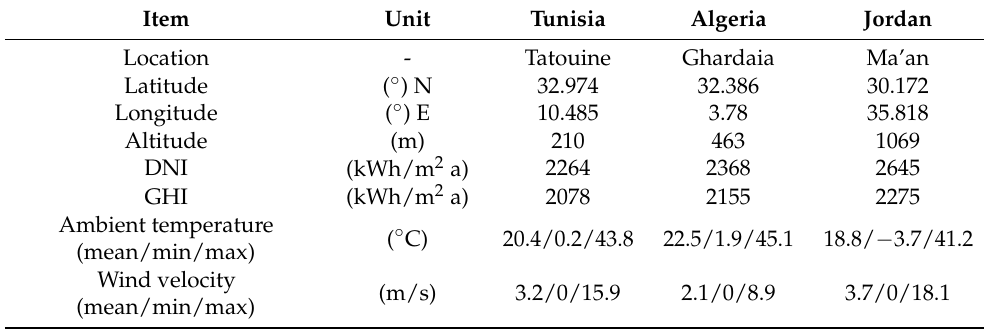
Table 1. Meteorological data of selected sites.